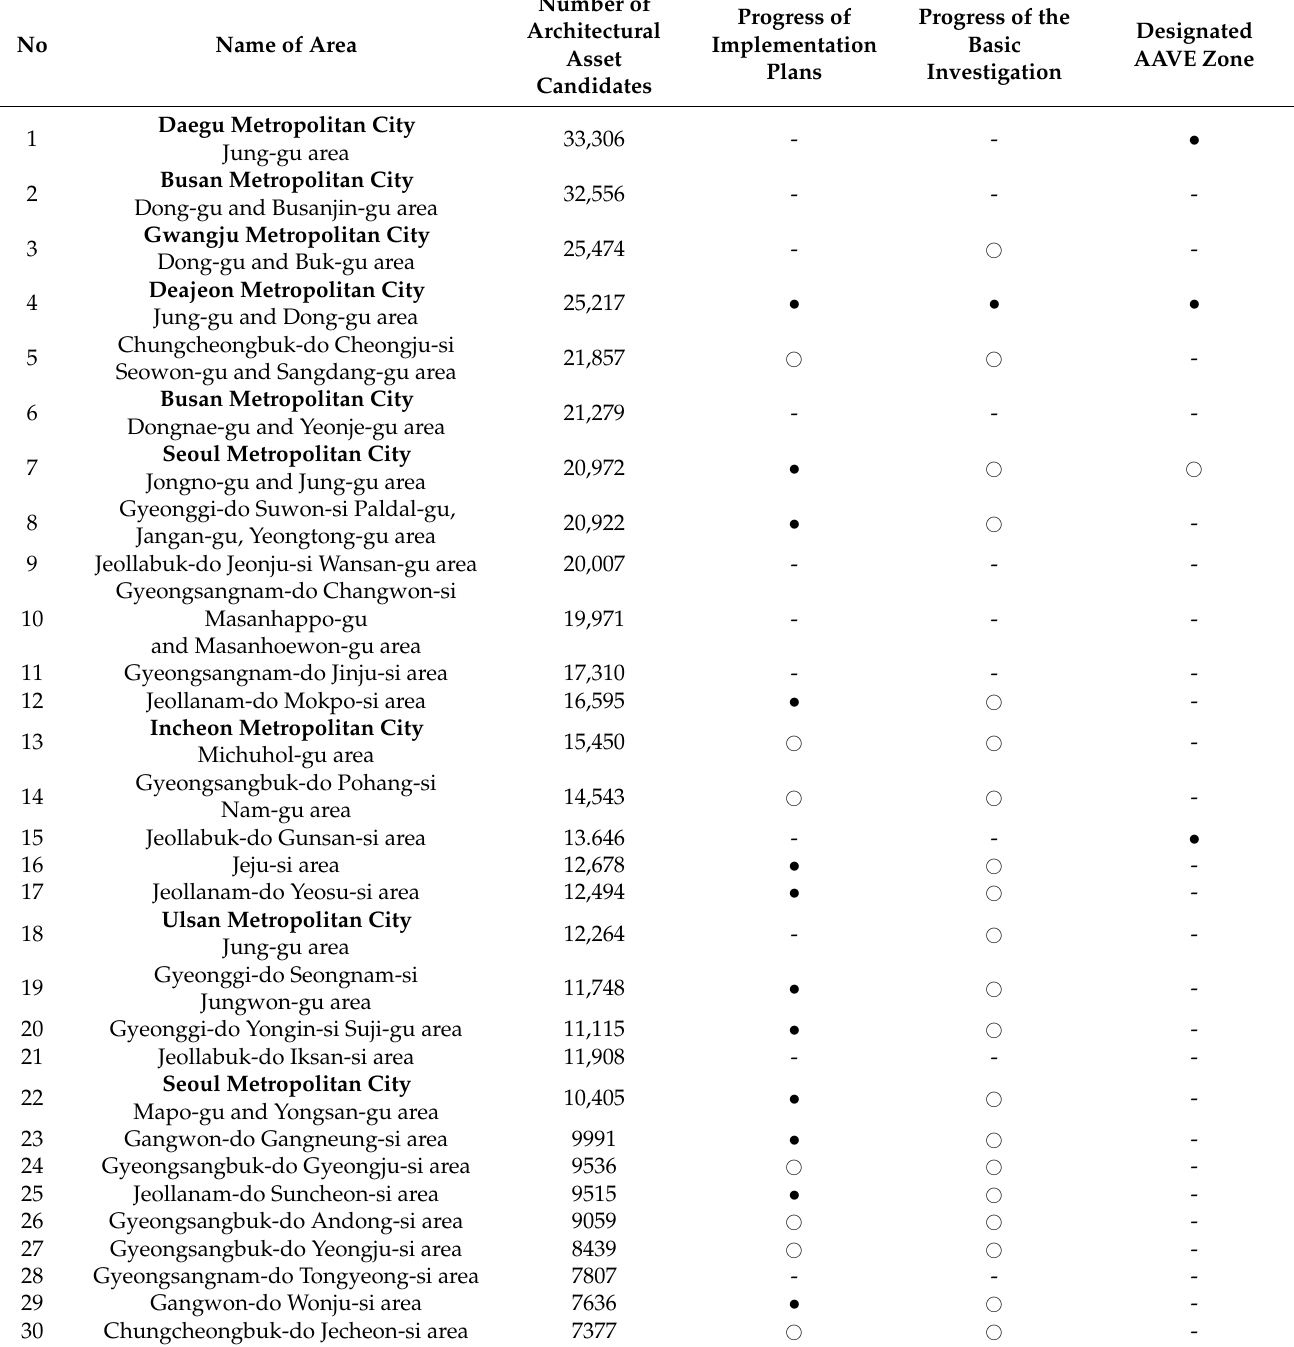
Table 2. Thirty regions with the largest number of architectural asset